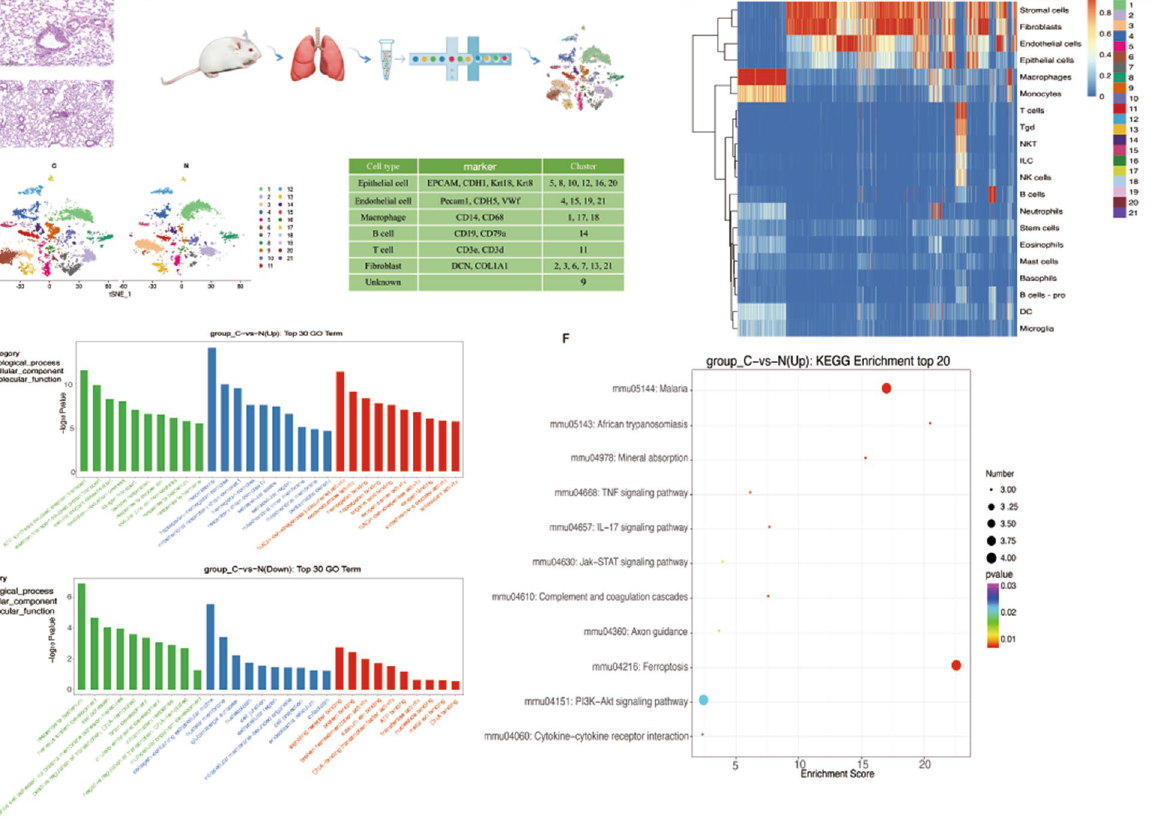
Figure 1. Single-cell transcriptomic atlas of mice lung tissues. ( A ) Lung histology 3 h after exposure to 400 ppm Cl 2 for 15 min, n = 6. ( B ) Flowchart of experiments in this study. ( C ) Unsupervised clustering of mice lung tissues revealed 21 distinct clusters. Cell name, marker genes and cluster of each cell type were summarized in the right panel. Raw data of cell types are shown in Supplementary information 2. ( D ) The heat map for identification of cell types. ( E ) The GO analysis of top 30 up-regulation and down-regulation in control and Cl 2 exposure groups. ( F ) The KEGG analysis of top 20 in control and Cl 2 exposure groups. N control group, C Cl 2